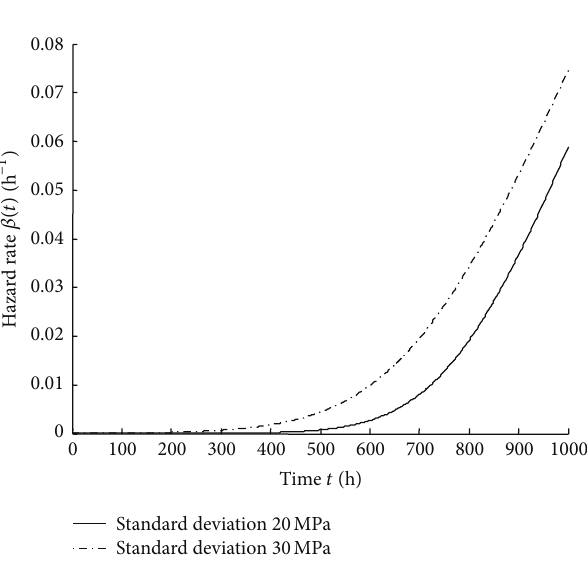
Figure 4: Hazard rate curves with different standard deviations of 𝑟 0